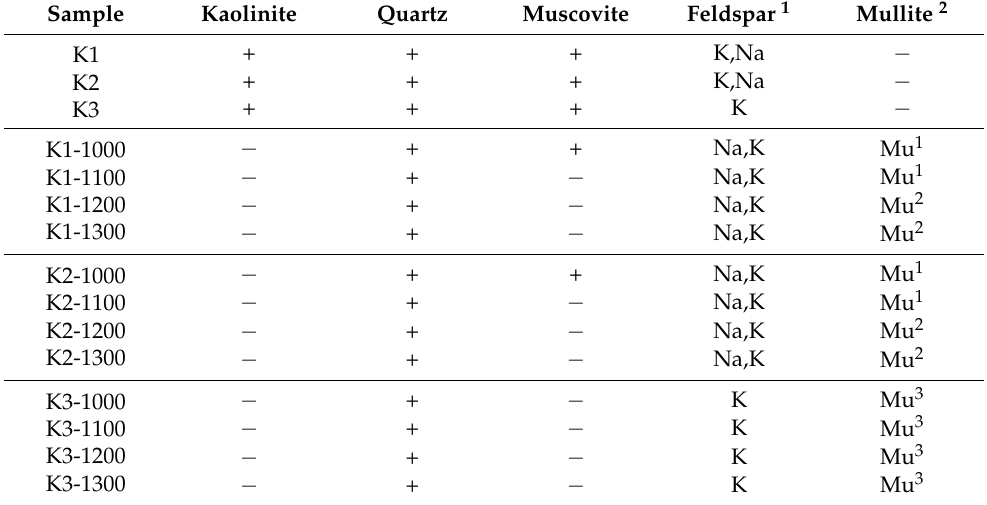
Table 2. Crystalline phases identified (+) and absent ( − ) in natural and annealed kaolin samples. Sample Kaolinite Quartz Muscovite Feldspar 1 Mullite